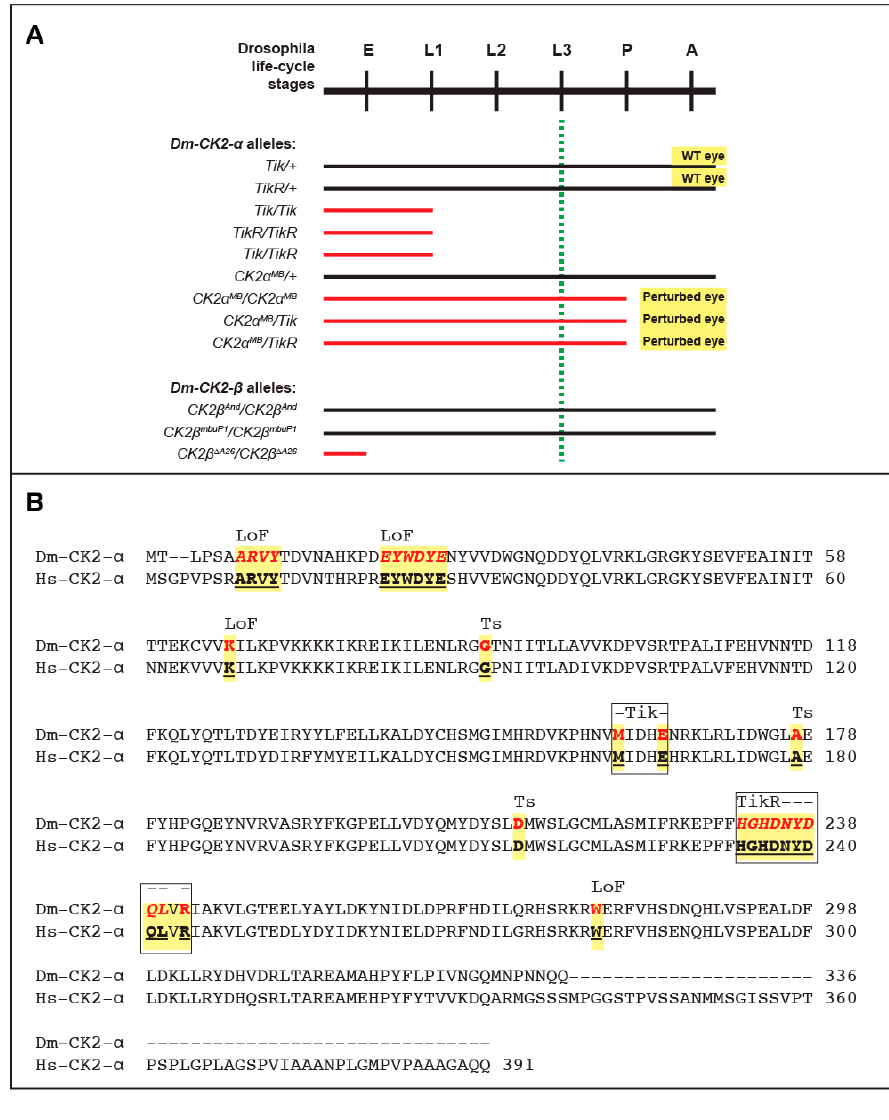
Figure 1. ( A ) Drosophila life cycle stages and effective lethal phase of CK2 mutants. Abbreviations are; E, Embryo; L1, 1st larval stage; L2, 2nd larval stage; L3, 3rd larval stage; P, pupal stage; A, adult. Note that Dm-CK2- α mutants Tik and TikR arrest at the L1 stage, whereas CK2 α MB mutants die at the P-to-A transition. In contrast, CK2 β And and CK2 β mbuP1 are viable, whereas CK2 β ∆ A26 die during embryogenesis. Dashed green line denotes stage of life cycle when eye development initiates; black lines denote normal development, whereas red lines denote effective lethal phases of indicated mutant combinations; ( B ) Alignment of CK2- α from D. melanogaster (Dm) and H. sapiens (Hs). LoF denotes loss-of-function, whereas Ts denotes Temperature-sensitive. The locations of the Tik and TikR mutations are boxed and yellow highlighting denotes conservation of residues between Dm and Hs CK2 α subunits.